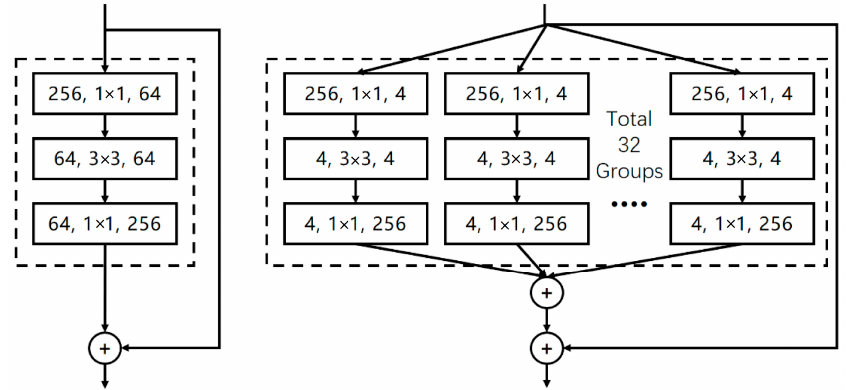
Figure 2. ResNet residual blocks ( left ) and ResNeXt residual blocks ( right ).